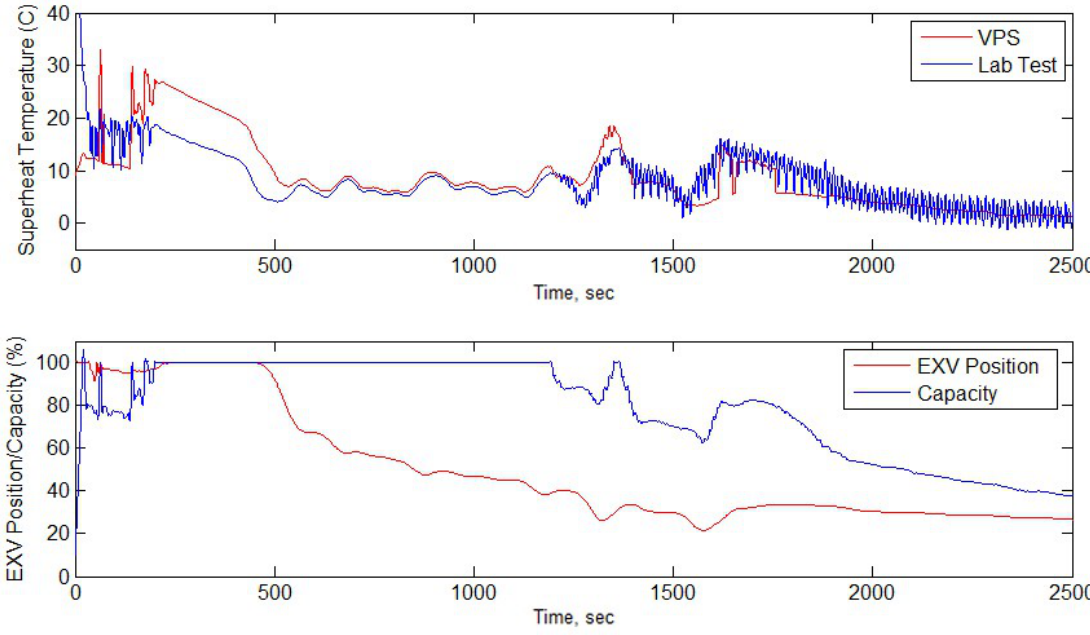
Figure 6. Test Case 3—superheat temperature estimation: VPS vs. test.